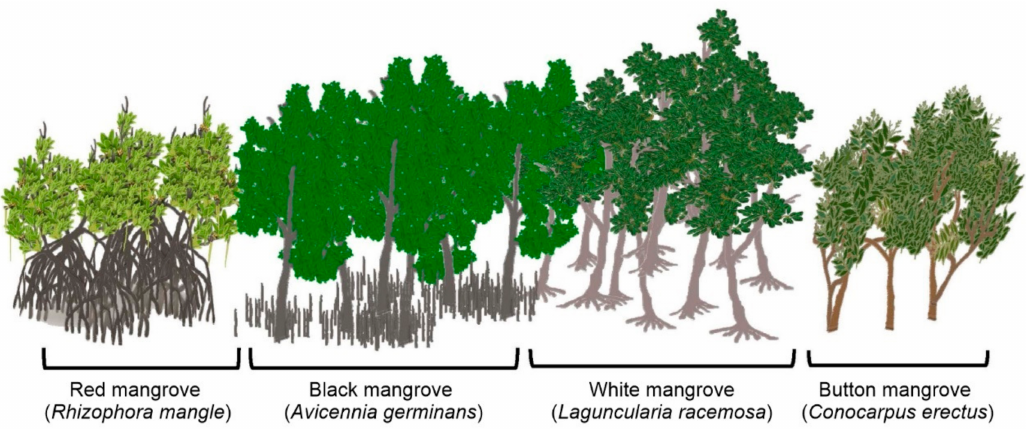
Figure 10. Distribution of mangrove species in La